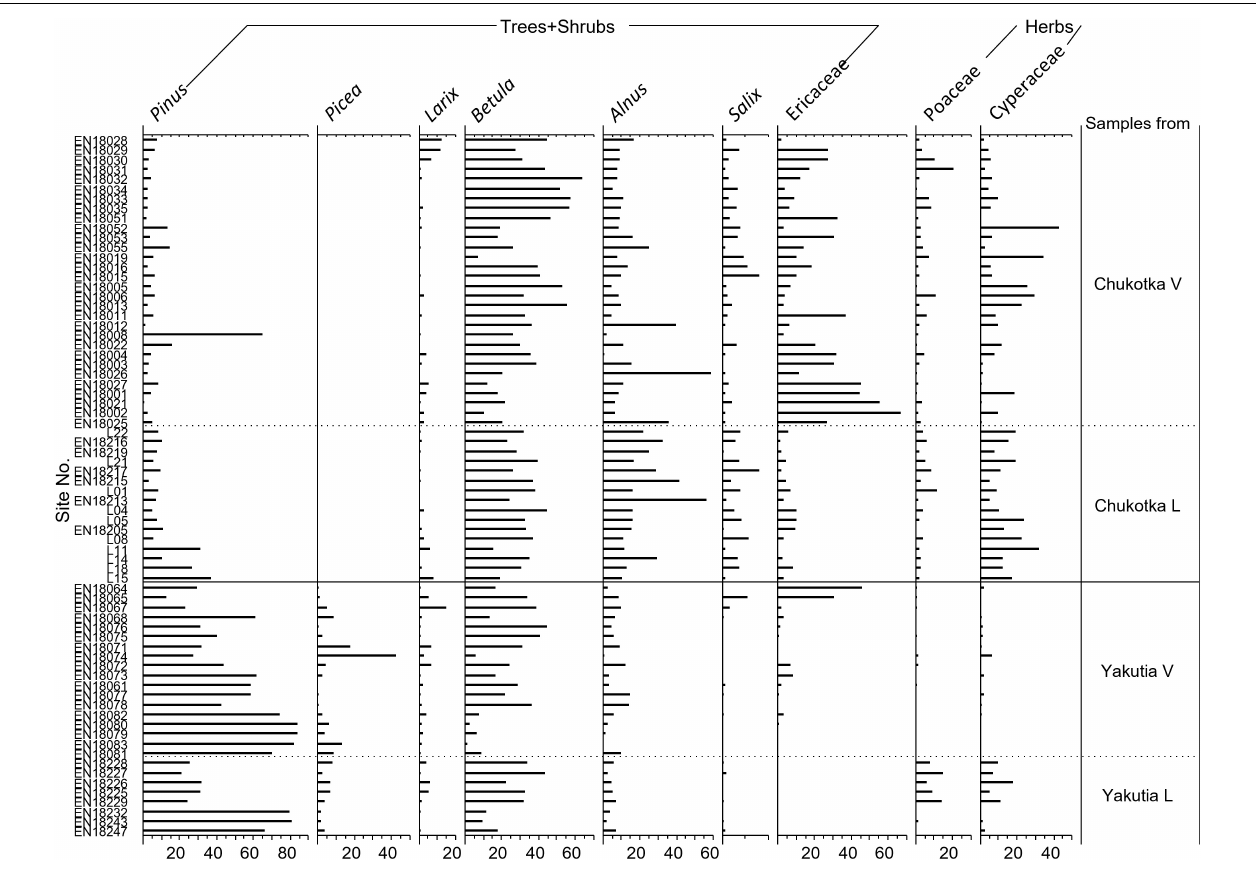
FIGURE 2 | Pollen diagram of the main taxa from 72 surface samples, grouped according to location. Suffix V signifies samples from vegetation plots, i.e., moss/soil samples and suffix L signifies lake sediment samples. Samples in each group are sorted by latitude in descending